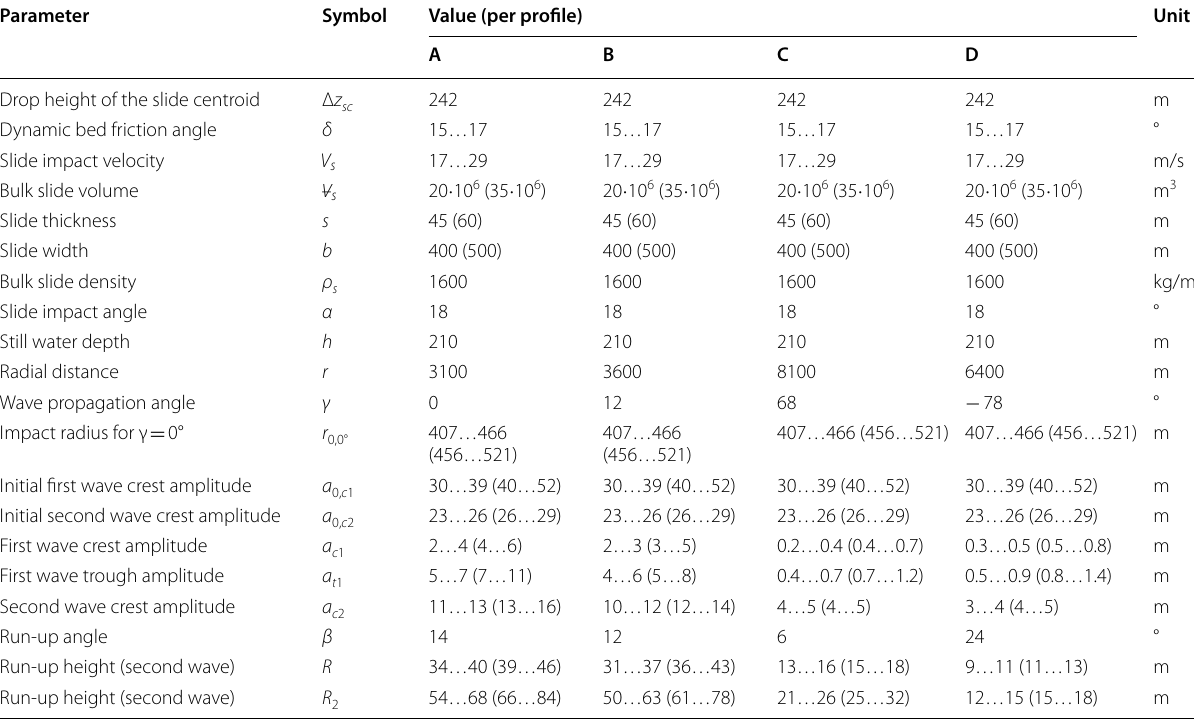
Table 2 Summary of the input parameters and estimated wave characteristics of the tsunami assessment for scenario I and scenario II (in